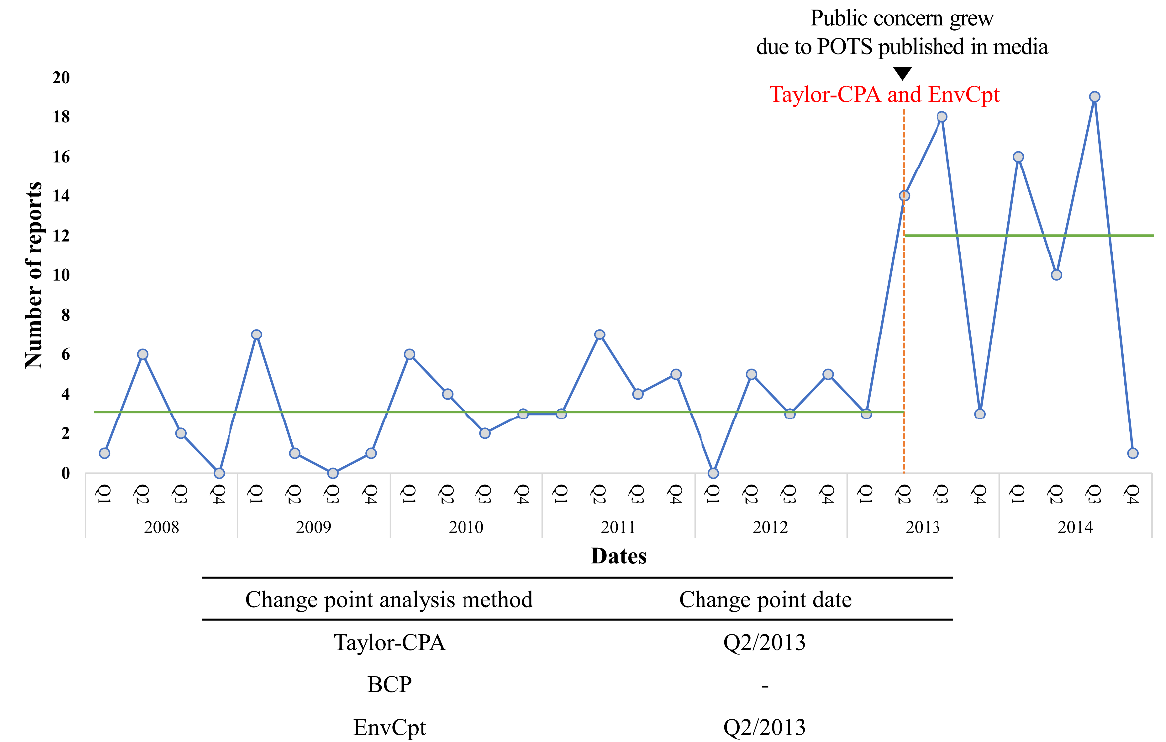
Figure 2. Change points detected by change point analysis based on the number of reports for the human papillomavirus vaccine including syncope and dizziness in individual case safety reports. Abbreviations: POTS, postural orthostatic tachycardia syndrome; BCP, Bayesian change point; Taylor-CPA, Taylor’s change point analysis; EnvCpt, environmental time series change point detection.